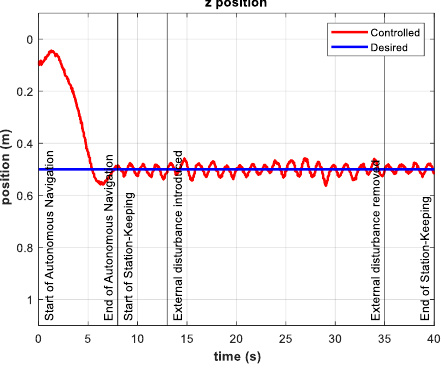
Figure 20. Experimental results for depth station-keeping with a time-varying external disturbance introduced in the interval 13 s ≤ 𝑡 ≤ 25 s . Depth ( left ) and tracking error ( right ).